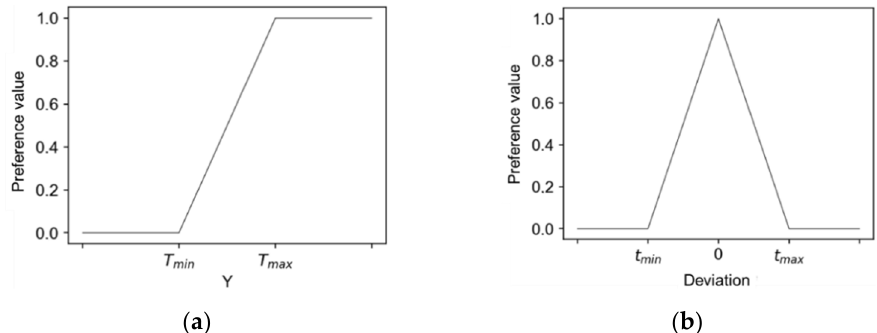
Figure 3. One-sided preference function ( a ), two-sided preference function ( b